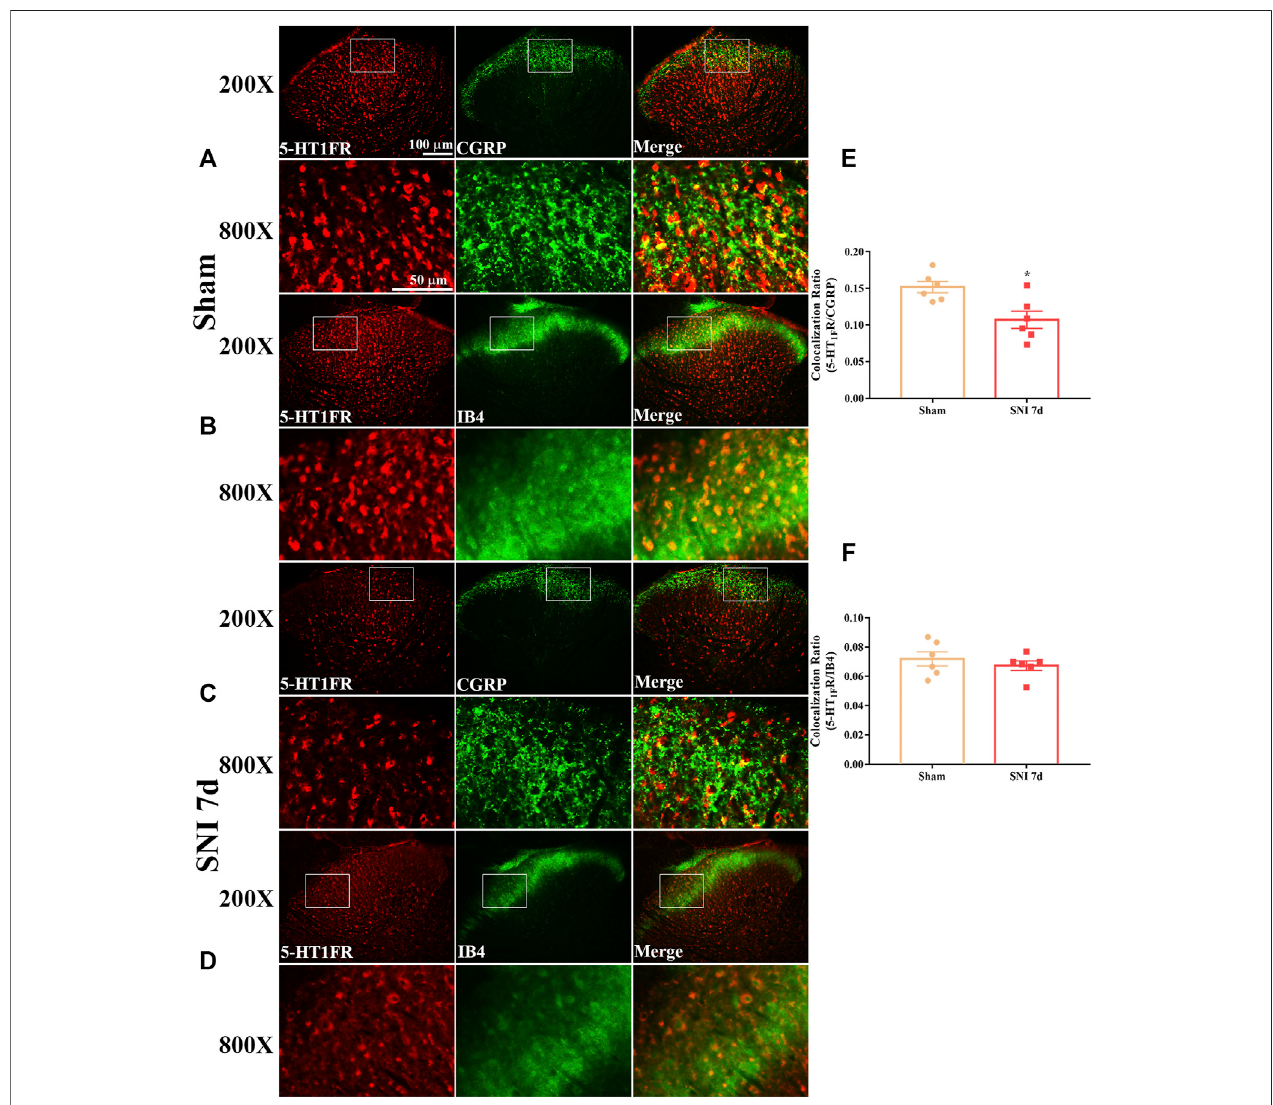
FIGURE 5 | Double immuno fl uorescence of 5-HT 1F receptor and CGRP and IB4 in the spinal cord of sham and neuropathic pain rats. (A) Double immuno fl uorescence of 5-HT 1F receptor and CGRP in the spinal cord of sham rats. (B) Double immuno fl uorescence of 5-HT 1F receptor and IB4 in the spinal cord of sham rats. (C) Double immuno fl uorescence of 5-HT 1F receptor and CGRP in the spinal cord of SNI rats. (D) Double immuno fl uorescence of 5-HT 1F receptor and IB4 in thespinalcordofSNIrats. (E,F)